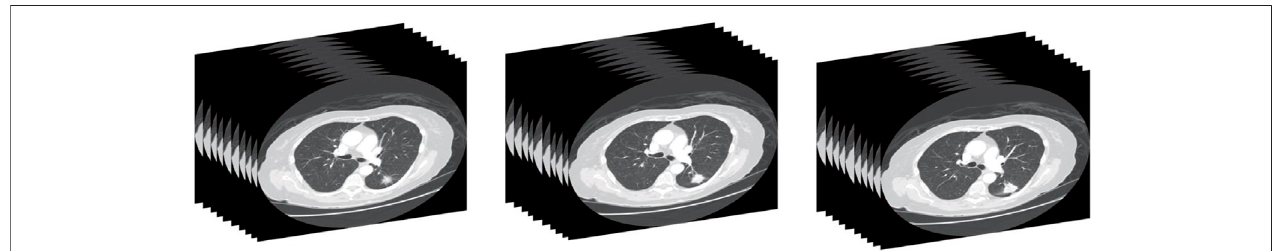
FIGURE 1 | Long-term sequence of lung